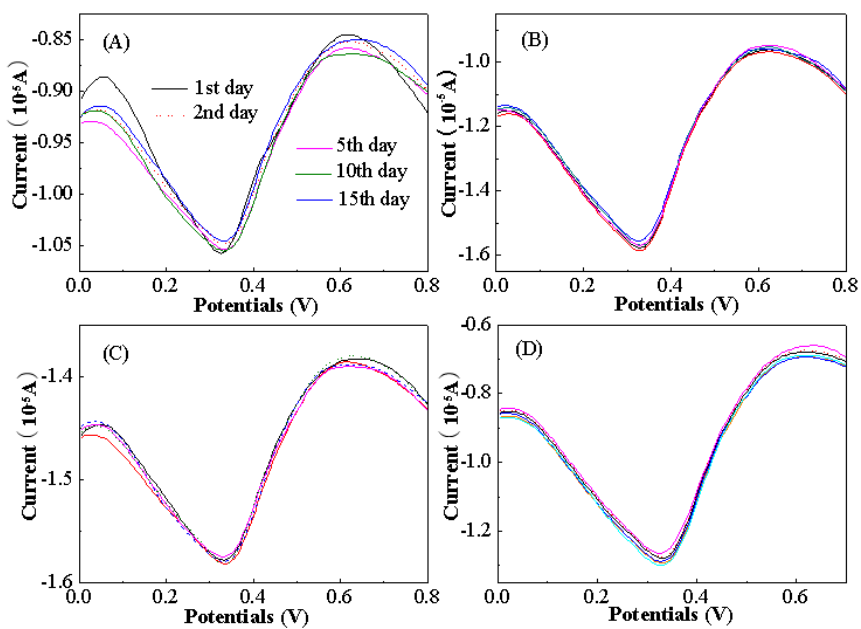
Figure 6. DPV profiles of C2 in PBS of pH 2.0 at a scan rate of 50 mV s − 1 . Aspartame concentration is 1 × 10 − 8 mol L − 1 unless otherwise specified. ( A ) at various time intervals from the 1st day to the 15th day in Coke Zero; ( B ) five measurements using the same C2 modified electrode in Coke Zero; ( C ) five measurements using the same C2 modified electrode in Sprite Zero; and ( D ) six modified electrodes fabricated individually in Coke Zero (the aspartame concentration: 1 × 10 − 6 mol L − 1